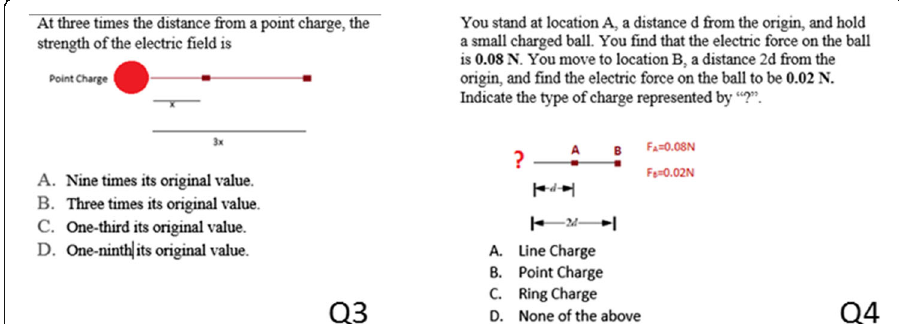
Fig. 4 Questions for point charge configuration. Q3 Source: Question developed by the researchers. Q4 Source: http://www4.ncsu.edu/~beichner/PY208/Docs/resources/Clicker%20Questions/ Clicker%20Questions.html